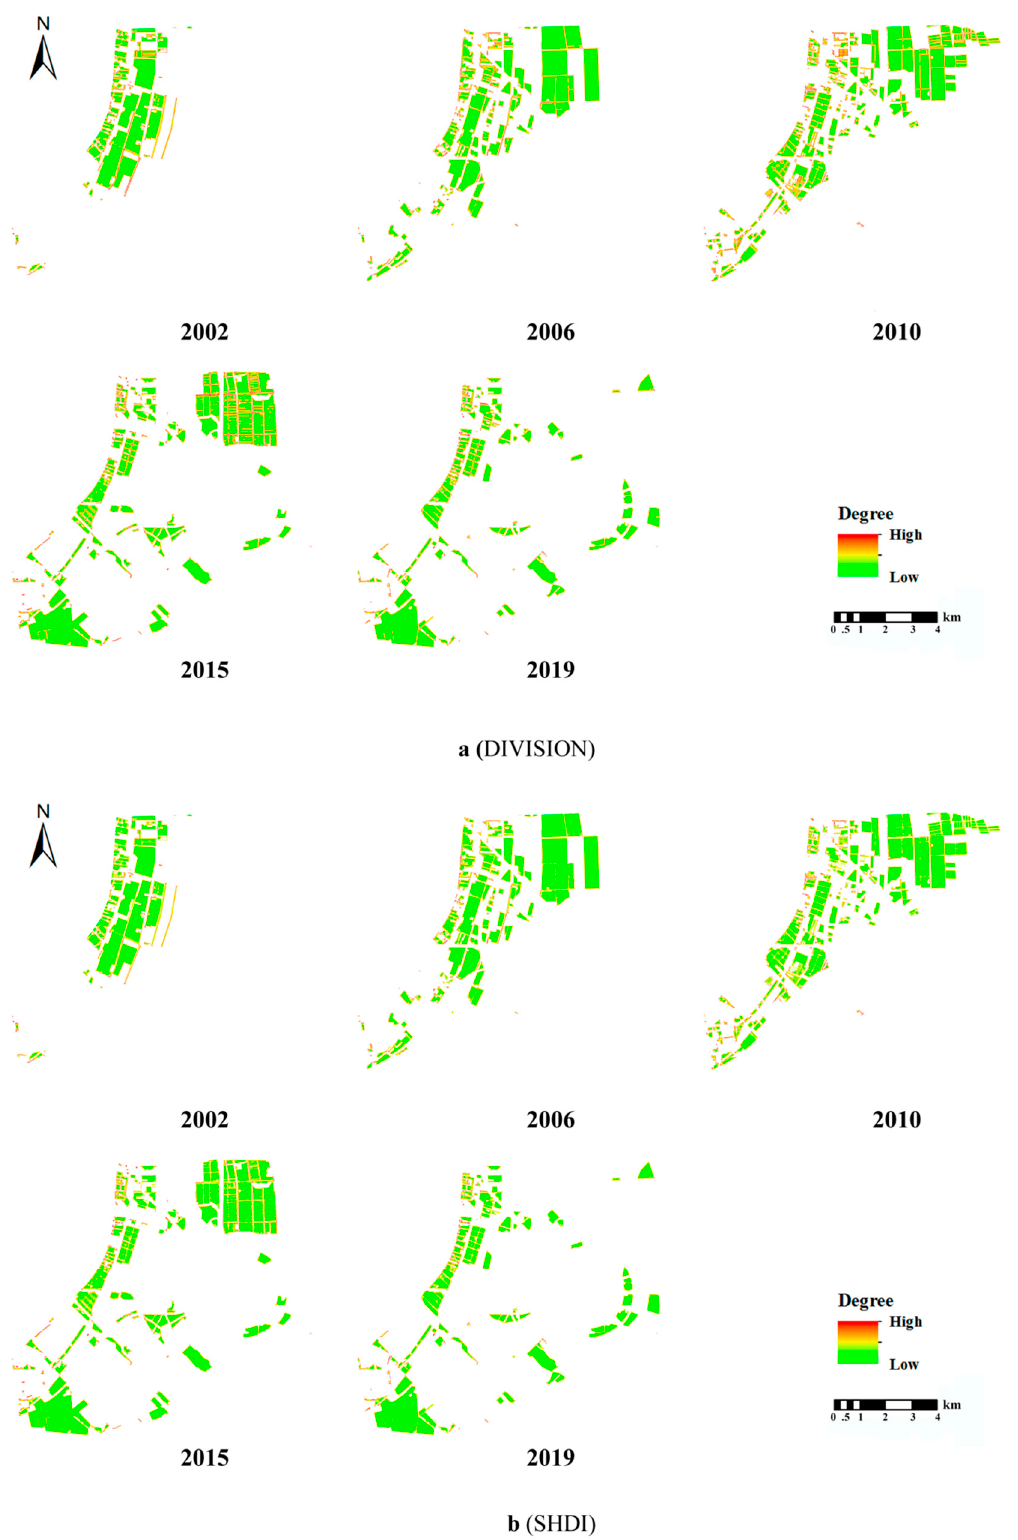
Figure 6. Spatial distribution of landscape fragmentation ( a ) (DIVISION) and diversity ( b ) (SHDI) of middle-level habi- tats.